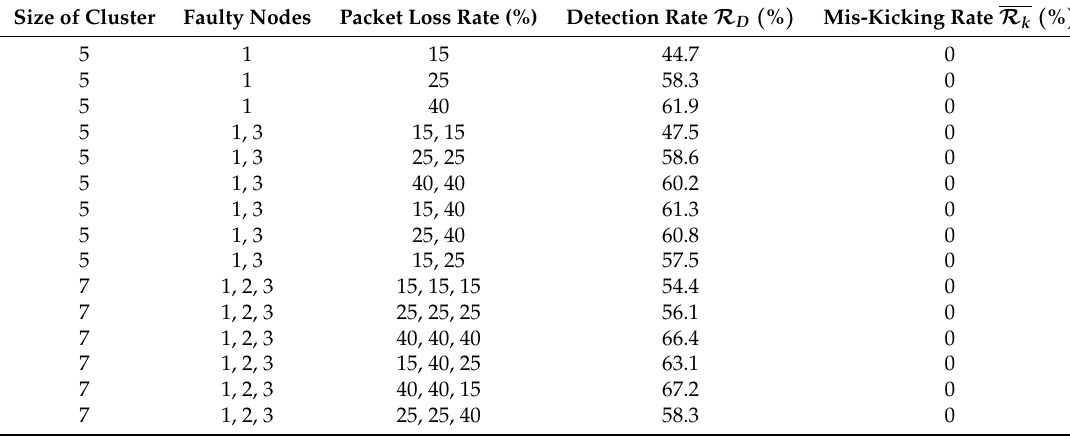
Table 7. The system-level testing results. Each group is tested for 12